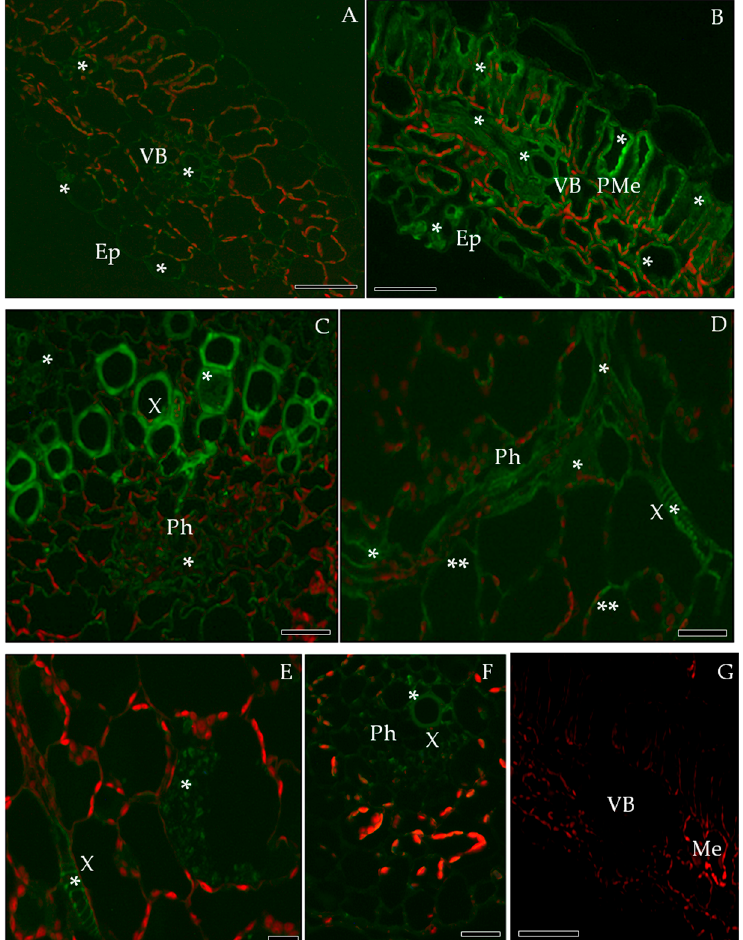
Figure 3. Immunofluorescence localization of PR-2 protein in potato-PVY NTN compatible ( B , C ) and incompatible interaction ( D – G ). ( A ) Green fluorescence signal of PR-2 in vascular bundles and epidermis (asterisk) of mock-inoculated potato leaf (control). Bar 200 µm. ( B ) Green fluorescence of PR-2 in palisade mesophyll, vascular bundle and epidermis with stomata (asterisk) of cv. Irys infected with PVY NTN . ( C ) Fluorescence PR-2 signal in xylem and phloem elements (asterisk) of potato Irys infected with PVY NTN . ( D ) PR-2 signal in phloem & xylem element (*) of S á rpo Mira inoculated with PVY NTN , also in the cell wall of spongy parenchyma cells (**). ( E ) PR-2 in the cell wall of xylem elements and in the symplast of spongy mesophyll. ( F ) PR-2 in the cell wall of phloem and xylem elements inside S á rpo Mira leaflets. Bar 200 µ m. ( G ) Control—lack of green fluorescence signal in hypersensitive response when primary antibodies were omitted. Bar 200 µ m.